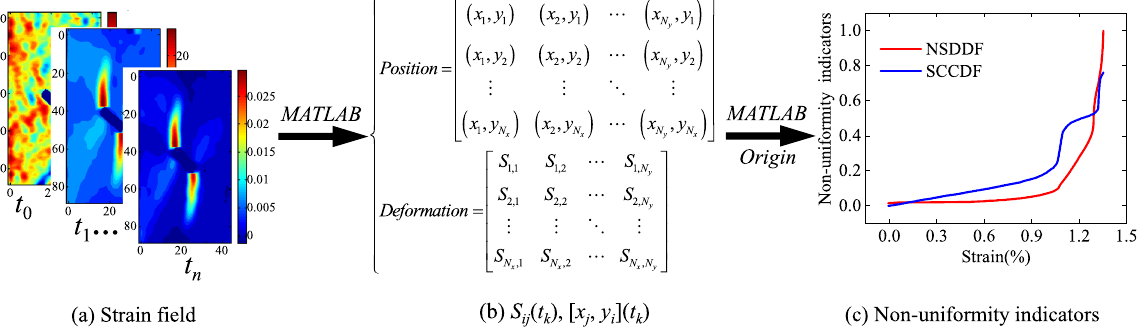
Figure 4. Flowchart of the proposed method for calculating heterogeneous deformation indicators.